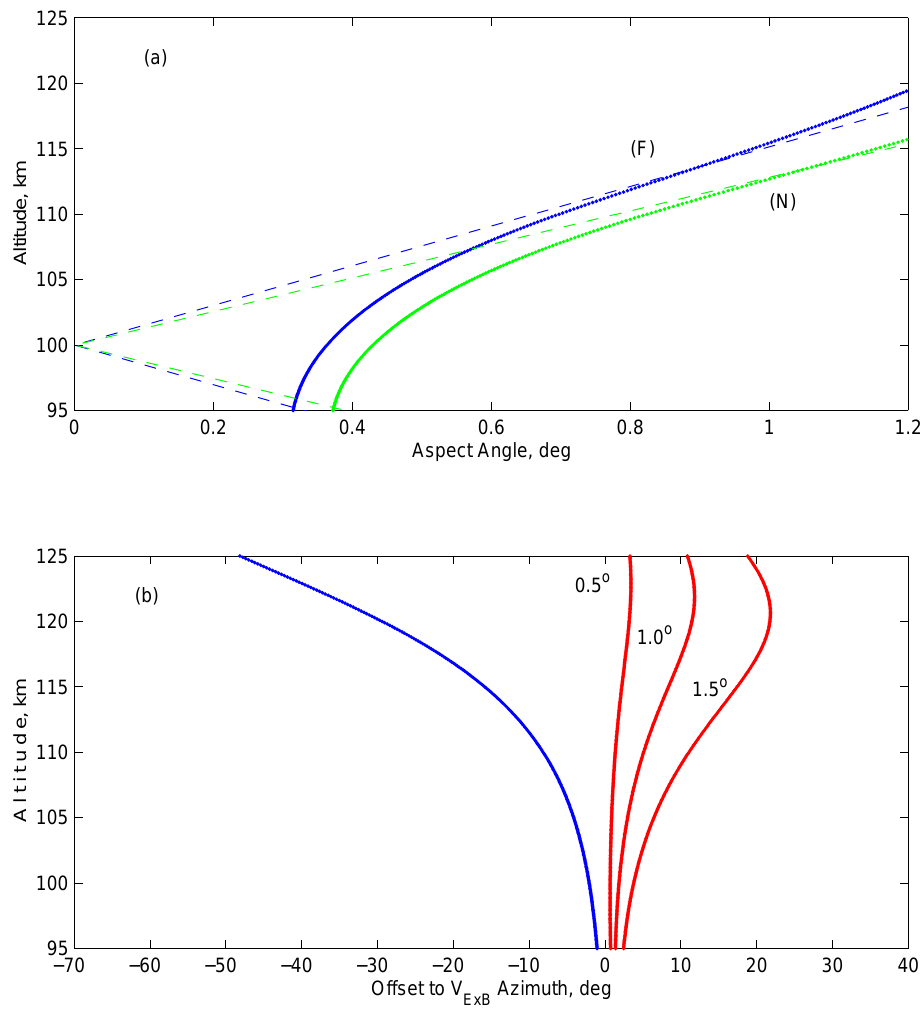
Fig. 5. (a) Rectilinear aspect angles (absolute values) for Finland (F) and Norway (N) radars at the EISCAT spot, dashed lines, and the Figure 5: Uspensky et al. effective aspect angles found from Eq. (2) as a function of altitude for a model parabolic N(h) -profile, (b) Azimuth of the largest phase velocity V ph with respect to the V E × B azimuth, red lines, aspect angles of 0.5, 1.0 and 1.5 ◦ , and the azimuth of the fastest F-B instability growth, blue line, derived from the linear fluid